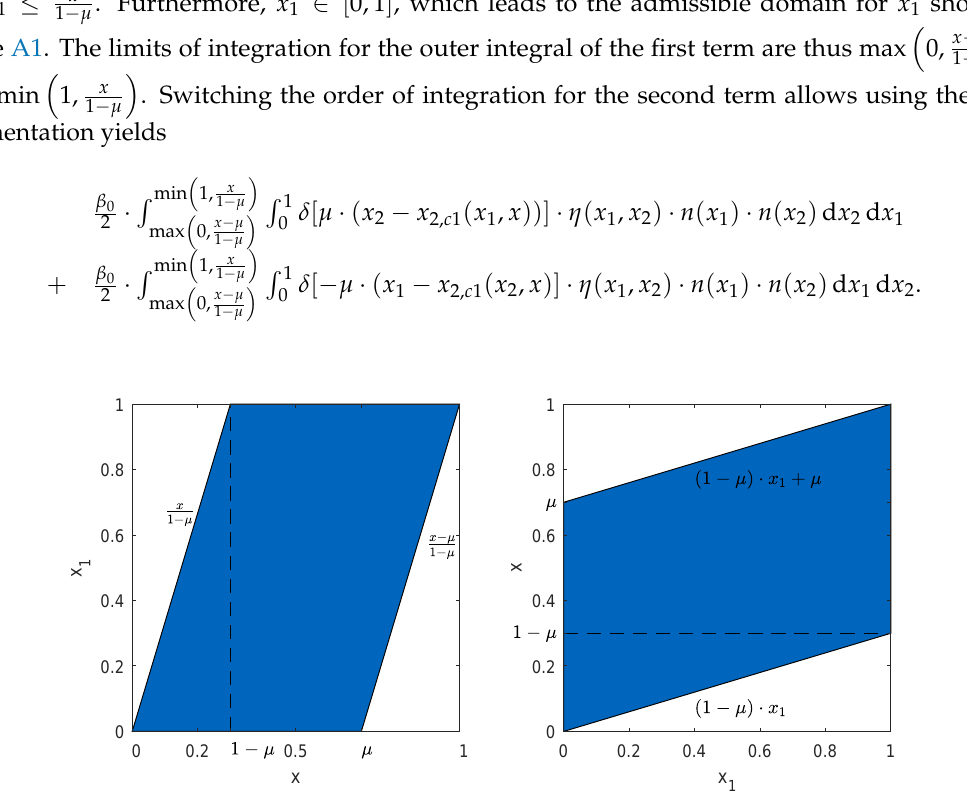
(cid:16) (cid:17) − µ ≤ 0, x 1 − µ